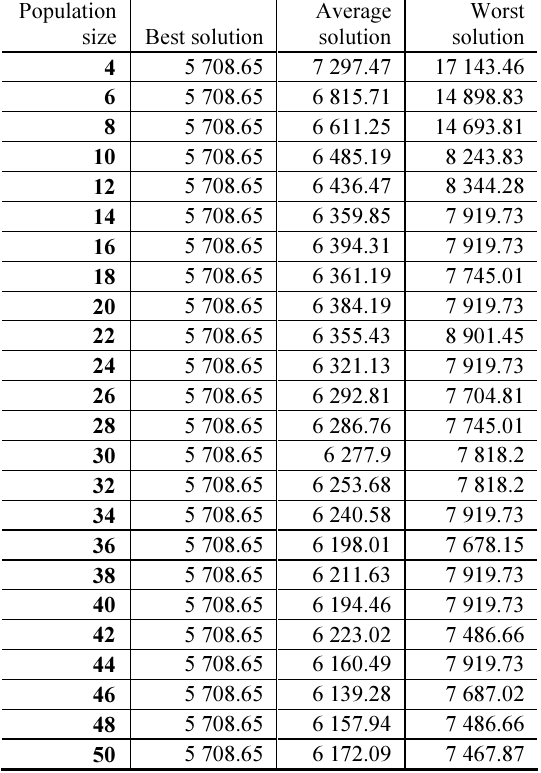
Table 4. Dependency of solution results on the population size Population